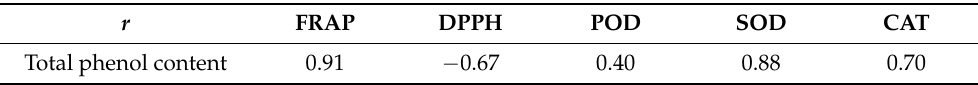
Table 2. C orrelation coefficient between antioxidant activity and phenolic content in D. forrestii shoot culture under various light conditions. r